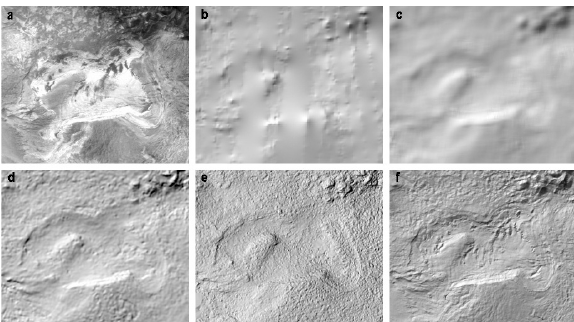
Figure 2. Details of Candor Chasma floor from Fig. 1. (a) Nadir image. (b) Shaded relief from MOLA DTM. (c) HRSC standard product from 2007. (d) USGS DTM from 2006. (e) USGS DTM from 2014 showing improved resolution. (f) 2006 DTM refined by photoclinometry (shape from shading) resulting in more realistic topographic details.